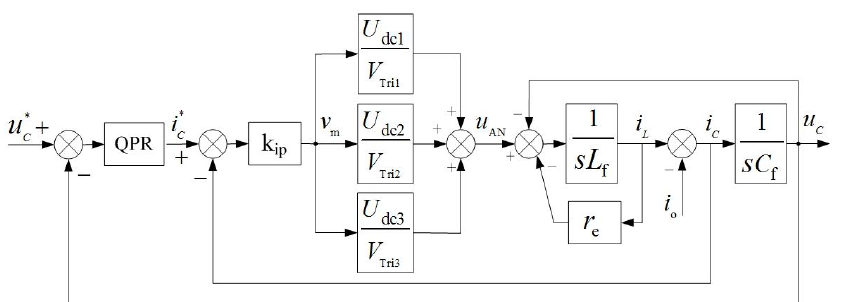
Figure 4. Master control block diagram of the inverter-link.